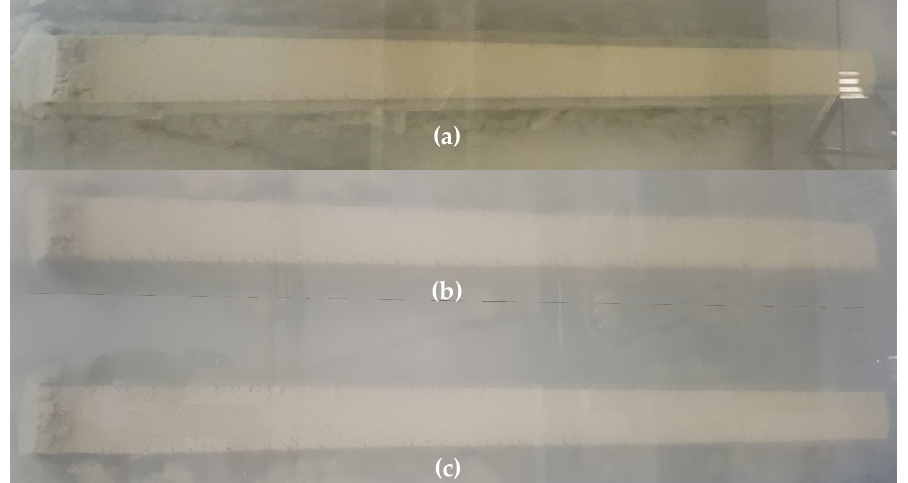
Figure 4. Parts additively manufactured underwater: ( a ) WP-4La; ( b ) WP-2La; ( c ) WP-2La-15.